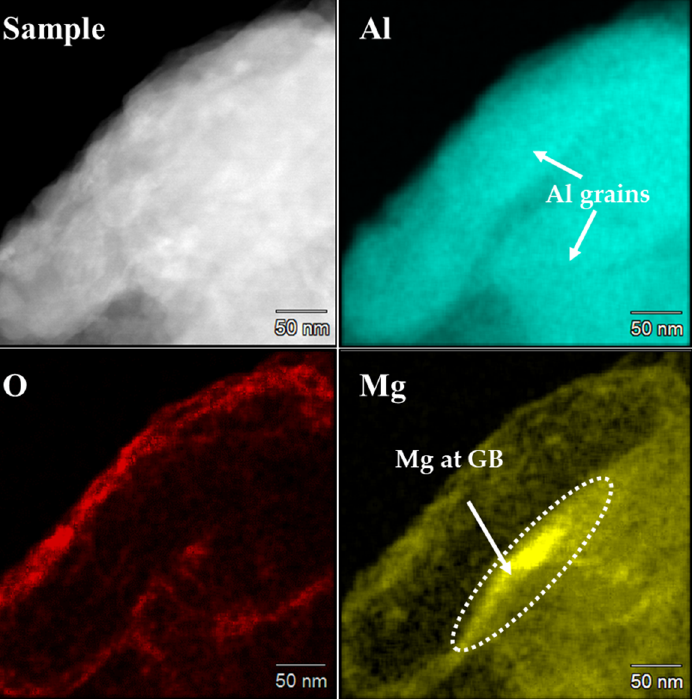
Figure 9. STEM-EDX plot showing the concentration of Mg dopant at the grain boundaries of Al